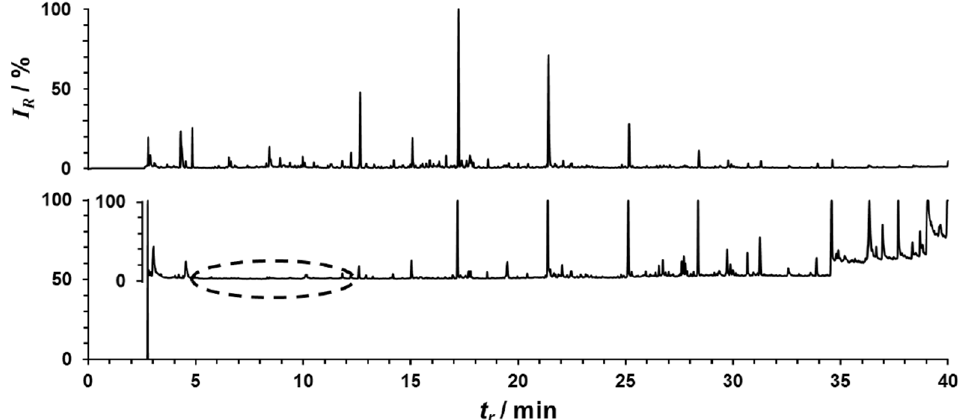
Figure 3. Example chromatograms to show an ejected breath sample due to excess solvent at 2.8 min (bottom) and a zoomed chromatogram for post-solvent peak responses (bottom inset) with a region of disrupted chromatography highlighted (dashed oval); and an acceptable exhaled breath sample from the same participant (middle). Note: I R = relative intensity; t r = retention time.